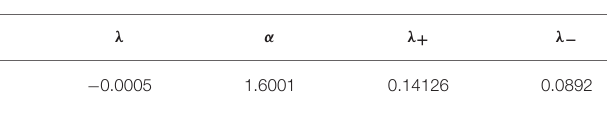
TABLE 11 | Calibrated parameters (CTS).